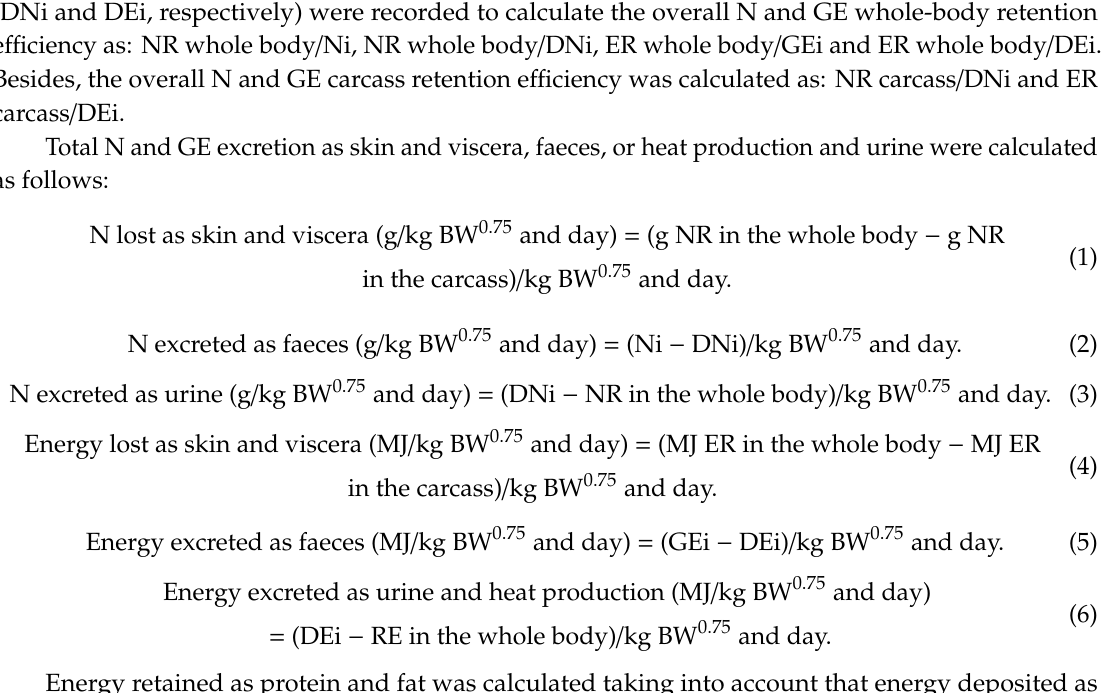
e ffi ciency as: NR whole body / Ni, NR whole body / DNi, ER whole body / GEi and ER whole body /